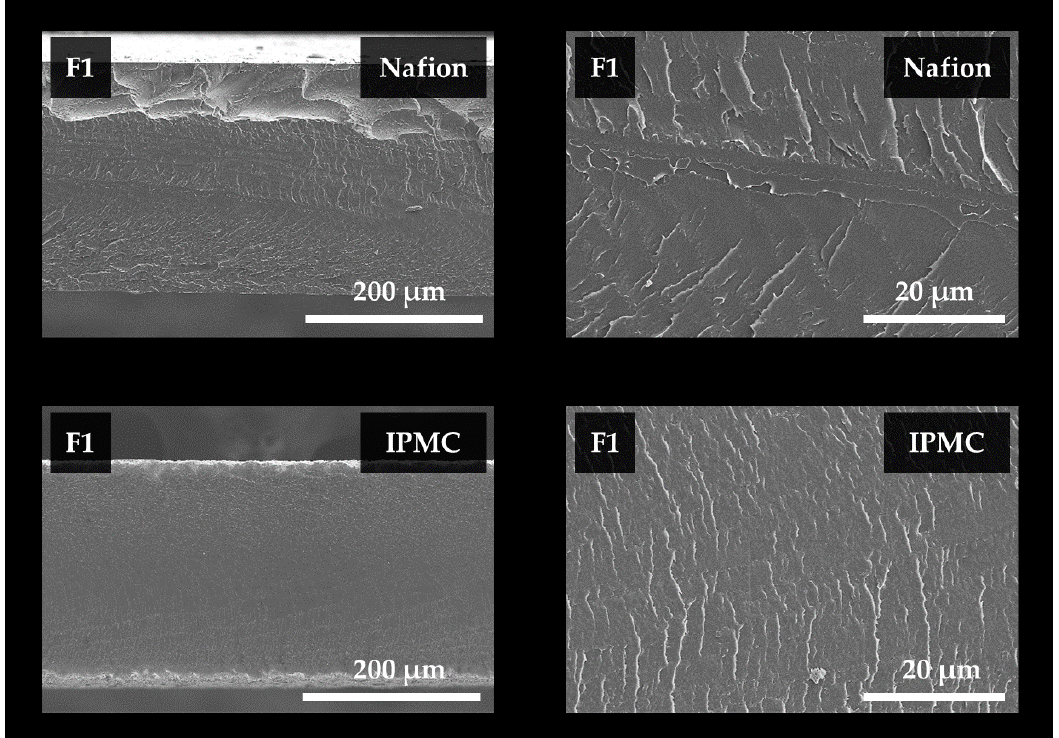
Figure 9. Scanning electron microscope observation image of the cross section of Nafion and IPMC specimens, according to the F1 foaming condition.